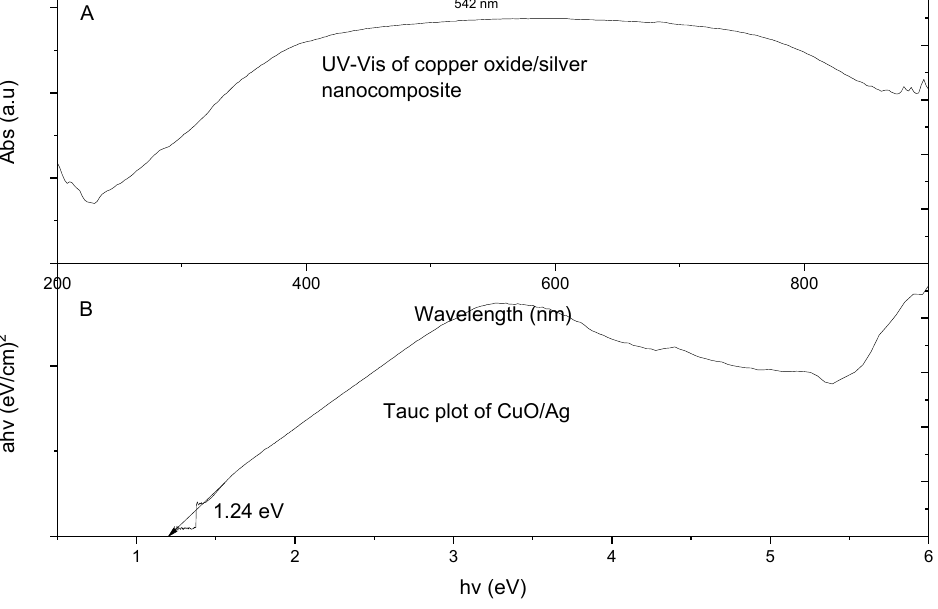
Figure 6. ( A ) Ultraviolet–visible (UV–Vis) spectrophotometric absorption spectra of CuO/Ag and ( B ) Tauc plot of CuO/Ag, adapted from reference